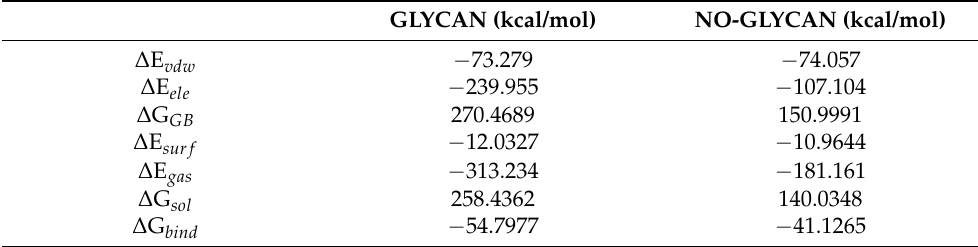
Table 1. Binding free energy of GLYCAN and